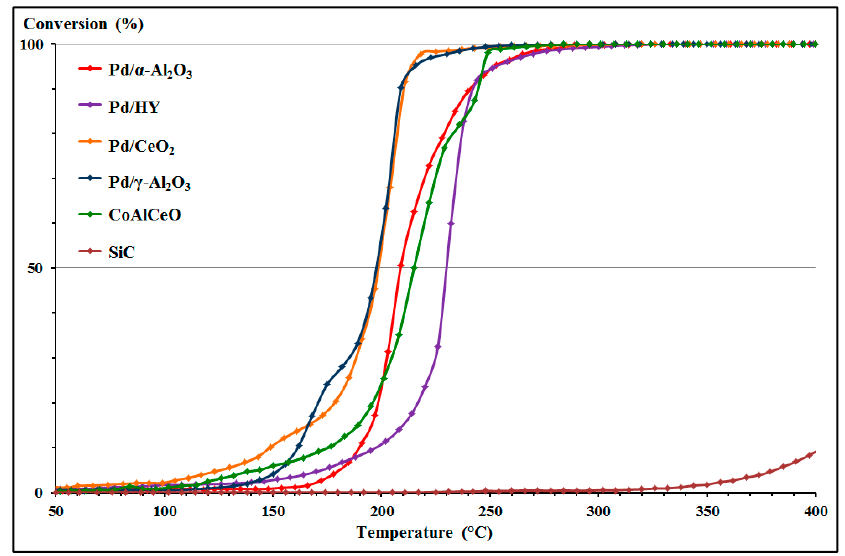
Figure 6. Light-off curves of binary mixture total oxidation. Table 6. T 50 and T 100 of catalysts for binary mixture and toluene catalytic oxidation.